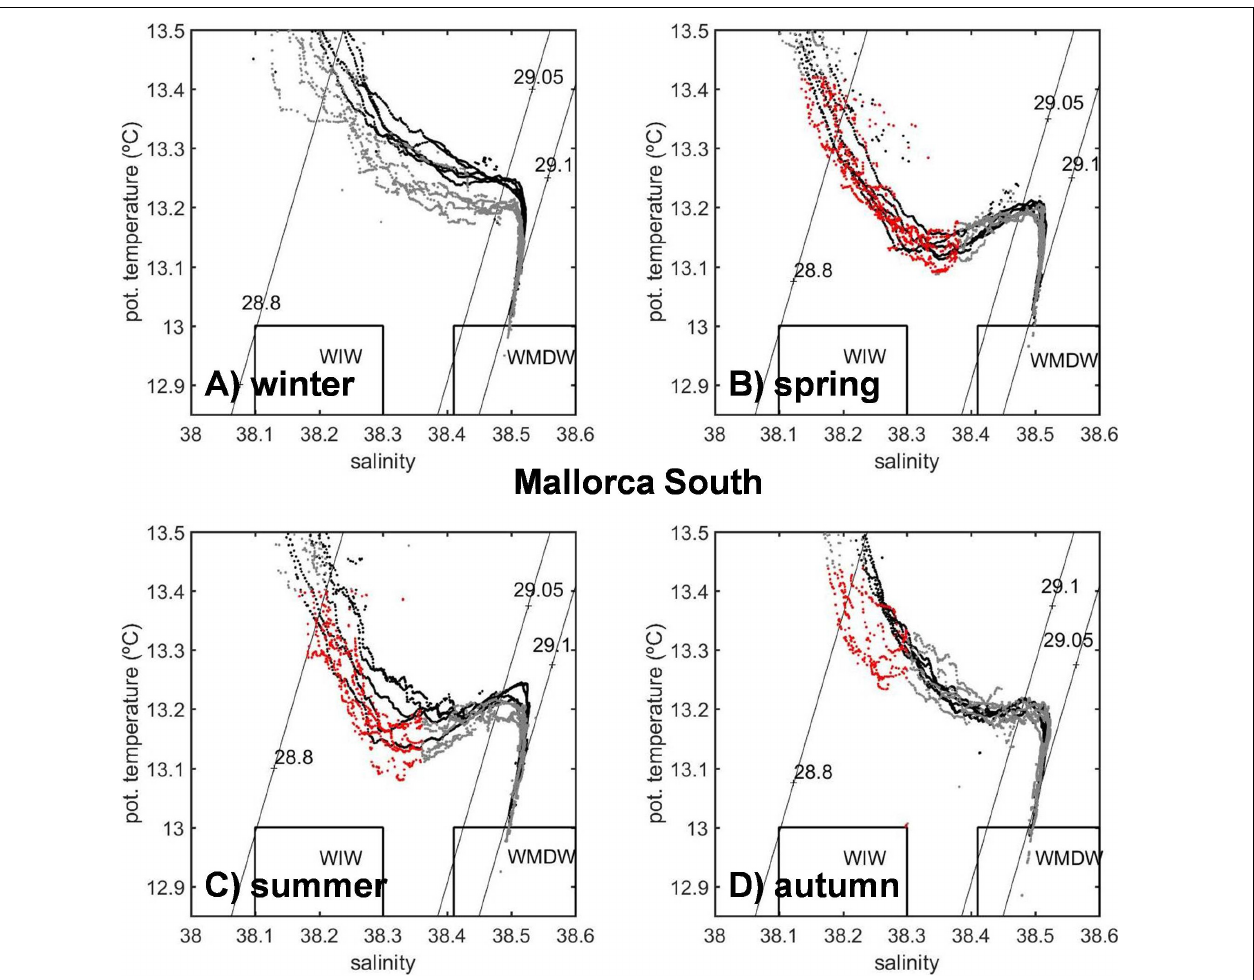
FIGURE 6 | θ S diagrams for the Mallorca South section in winter (A) , spring (B) , summer (C), and autumn (D) . The upper 100 dbar have been removed to focus on the characteristics of intermediate and deep waters. σ θ contours for sigma-theta values 28.8, 29.05, and 29.1 have been included to show the layers corresponding to the WIW (28.8–29.05), LIW (29.05–29.1), and WMDW ( > 29.1) according to Pinot and Ganachaud (1999) and Pinot et al. (2002) criterion. Gray dots are median values, black dots are mean values and red dots are those values corresponding to WIW as detected by the geometry-based method in Juza et al. (2019). Median and mean values have been calculated for each oceanographic station and depth level within each hydrographic section. Two boxes indicating the θ S ranges for WIW (according to López-Jurado et al., 1995) and the ranges for the WMDW (Pinot et al., 2002) have been included.